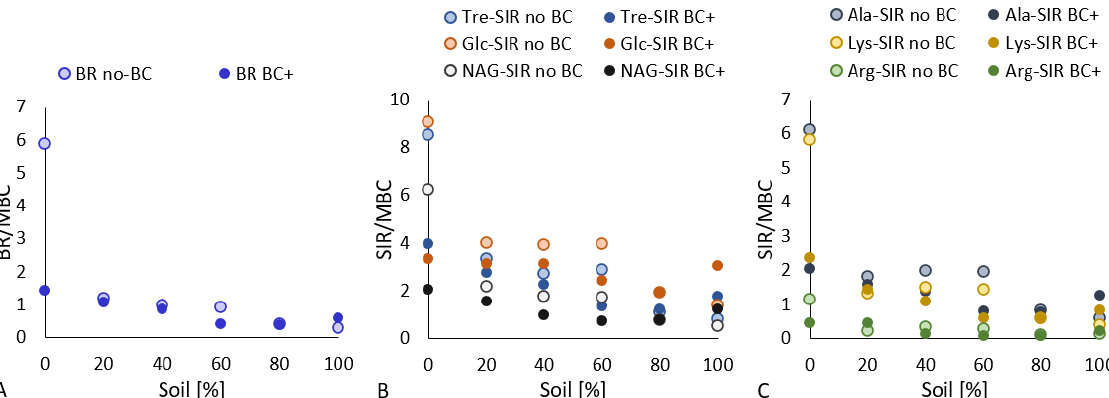
Figure 5. The dependence of the metabolic (basal ( A ) and substrate-induced ( B and C ) quotients (respiration and MBC ratio) on the sand:soil ratio (expressed as a percentage of soil) and biochar amendment.